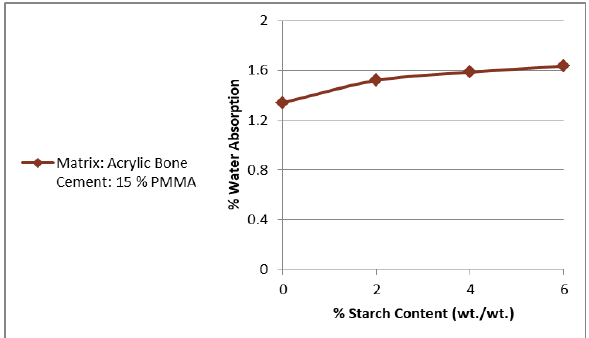
Figure, 7: Water absorption of (Acrylic bone cement: 15 % PMMA: % X starch) as a function of starch material content in